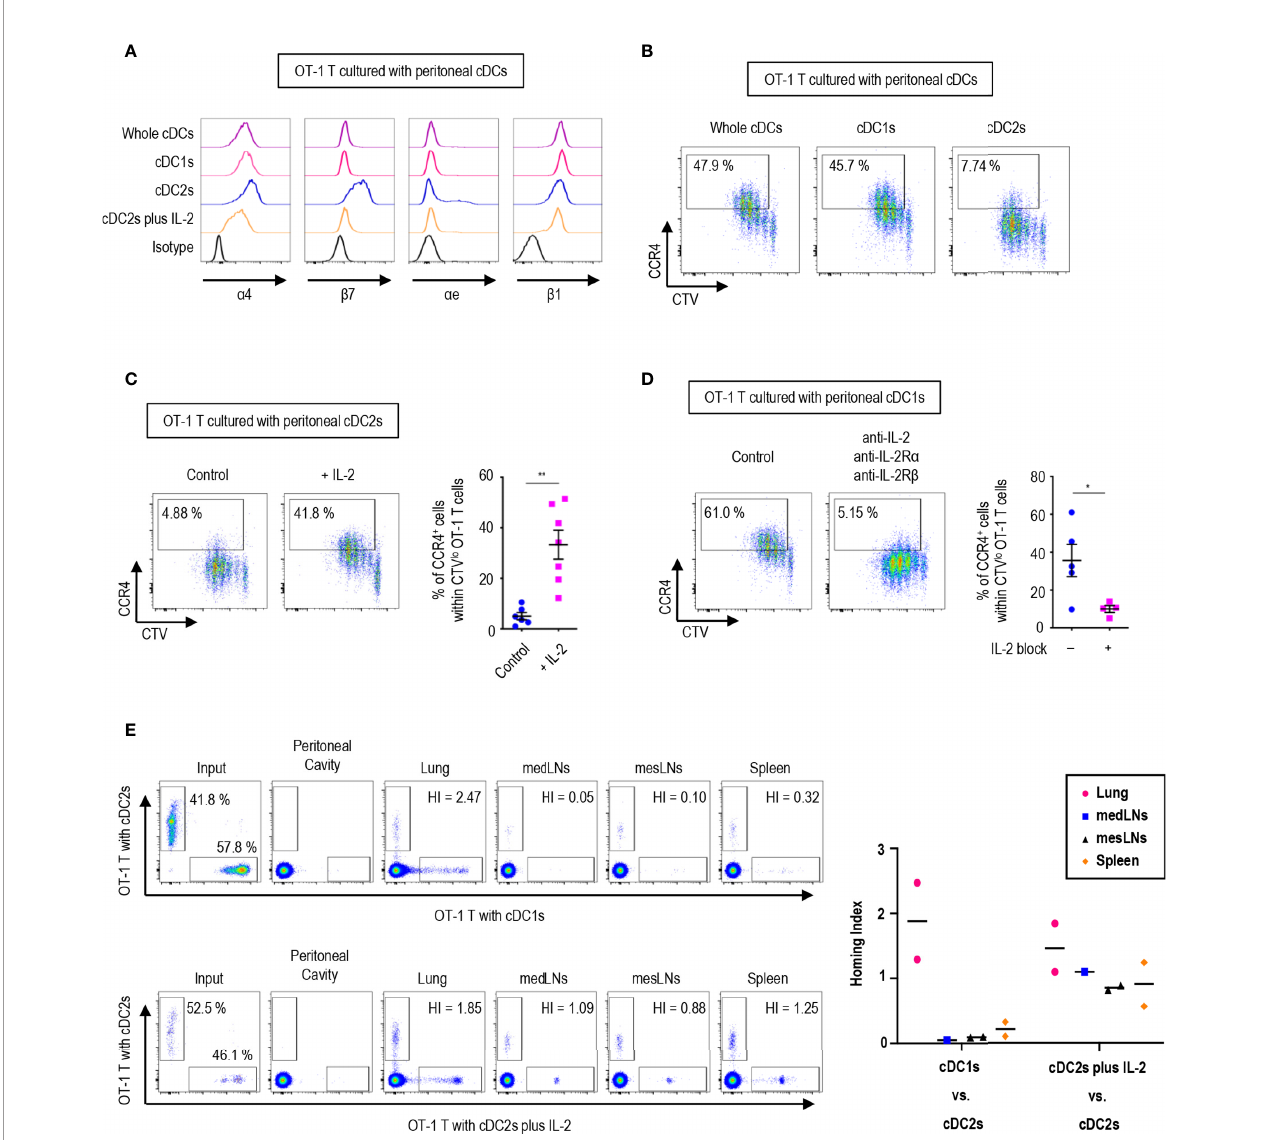
FIGURE 5 | PeritonealcDCsinduceCD8Tcellswithdistincthomingproperties.1.5mgofOVA(GradeV)wasinjectedintotheperitonealcavityforanhour.OVA-ladenperitoneal cDCsubsetswereisolatedandco-culturedwithnaïveOT-1Tcellsfor3daysbeforeanalysis. (A) OT-1TcellsstimulatedbycDCswerestainedforintegrins a 4, b 7, a e,and b 1 (representativeofmorethan3independentexperiments). (B) SurfaceexpressionofCCR4inOT-1TcellsstimulatedbyperitonealcDCsareshown(representativeof4independent experiments). (C) EffectofIL-2onCCR4expression.OT-1TcellsandperitonealcDC2swereco-culturedwithorwithout100ng/mlofIL-2for3days.LiveCTV lo CD8 + Tcellsare plottedandthepercentagesofcellsexpressingCCR4amongCTV lo proliferatedOT-1Tcellsareshowninagraph.Dataarepooledfrom2independentexperiments(n ≥ 6).Error barsindicatemean±SEM. (D) ExpressionofCCR4onOT-1TcellsstimulatedbyperitonealcDC1swhileblockingIL-2signaling.OT-1TcellsandperitonealcDC1swereco- culturedwithantibodiesblockingIL-2signaling(2 m g/mlofpolyclonalanti-IL-2,10 m g/mlofPC61anti-IL-2R a ,and10 m g/mlofTmB1anti-IL-2R b )for3days.LiveCTV lo CD8 + Tcells areplottedandthepercentagesofcellsexpressingCCR4amongCTV lo proliferatedOT-1Tcellsareshowninagraph.Dataarepooledfrom2independentexperiments(n ≥ 4). Errorbarsindicatemean±SEM. (E) Homingindex(HI)measuredbycompetitiveadoptivetransferexperiments.OT-1TcellswerestimulatedbycDC2s(labeledwithCFSE),cDC1s (labeledwithCTV),orcDC2splusIL-2(labeledwithCTV).LabeledOT-1Tcellsweremixed1:1andadoptivelytransferredintravenously(i.v.)intorecipientmice.Atotalof500,000 cellscontaininganequalmixtureofOT-1TcellsrespectivelystimulatedbycDC1svs.cDC2s(upperpanels)oratotalof1,000,000cellscontaininganequalmixtureofOT-1Tcells respectivelystimulatedbycDC2splusIL-2vs.cDC2s(lowerpanels)wereadoptivelytransferred.After3hoursofcompetitiveadoptivetransfer,HIofeachtissuewasdetermined. HIwascalculatedas[CTV + /CFSE + ] tissue /[CTV + /CFSE + ] input